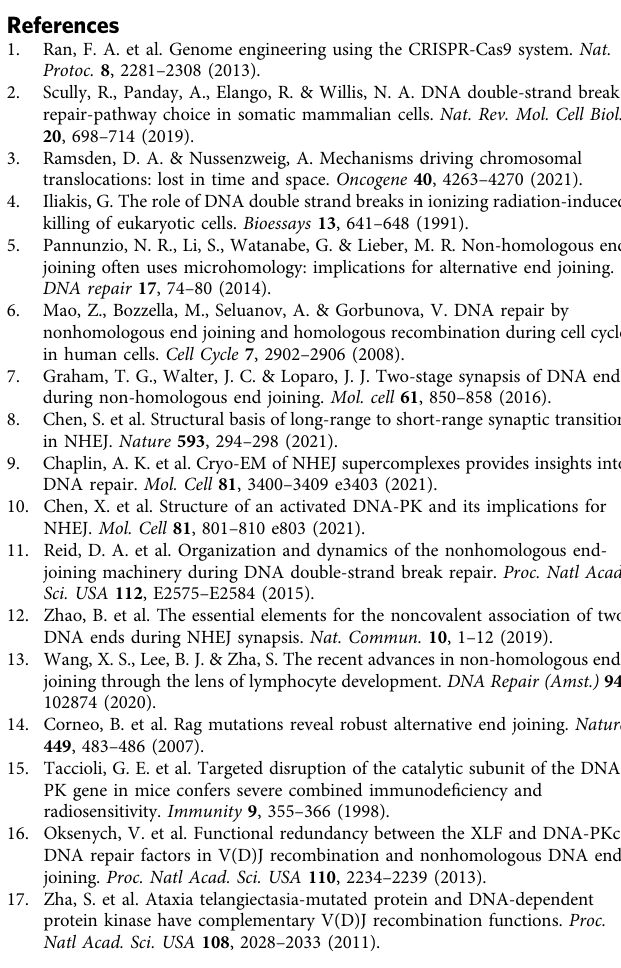
GAPDH-CD4 rearrangement junction analysis . CD4 + cells isolated following the DSB reporter assay described above were used to purify genomic DNA, as described 29 , and the GAPDH-CD4 rearrangement junction was ampli fi ed with ILL-GAPDH and ILL-CD4 primers, which include the Illumina adapter